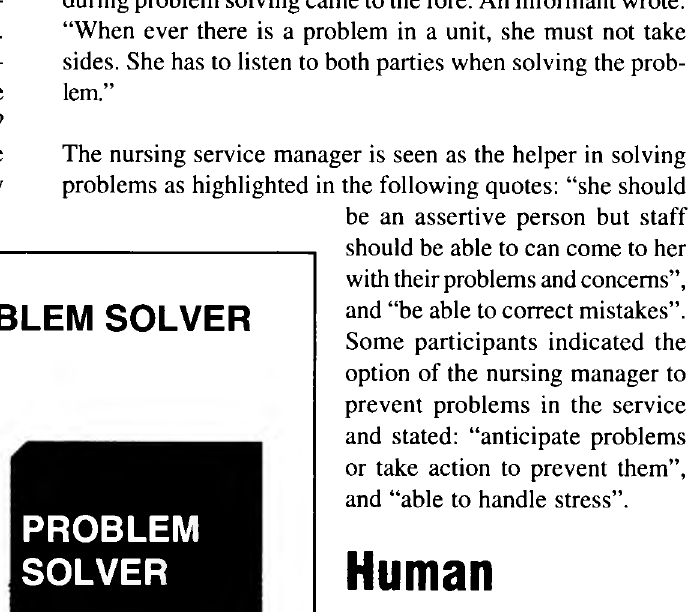
FIGURE 5: ATTRIBUTES OF A PROBLEM